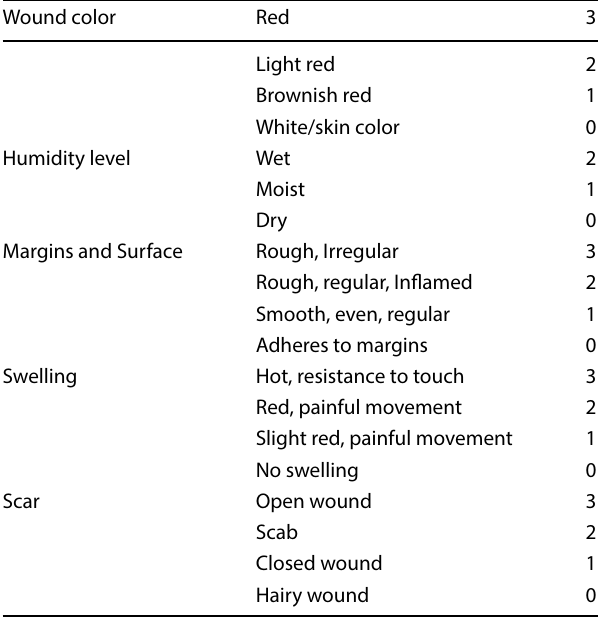
Table 1 Clinical parameters for qualitative analysis of wound heal- ing [9, 10] Wound color